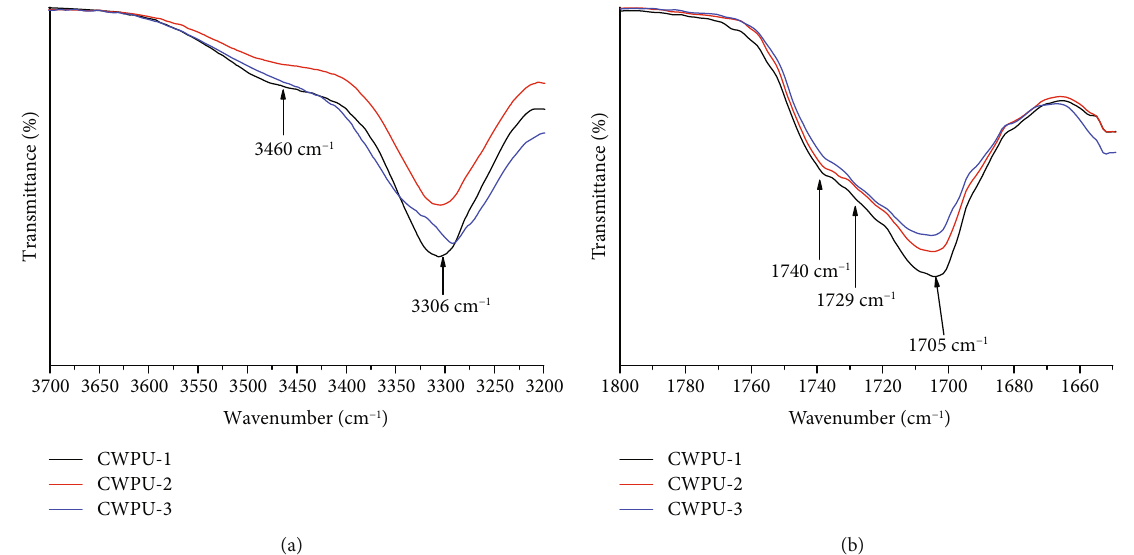
Figure 5: FT-IR spectra of cationic waterborne polyurethanes (CWPUs) with various internal emulsi fi er contents in (a) N-H stretching region and (b) C=O stretching region.